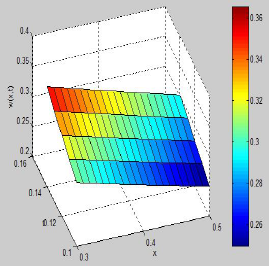
Fig. 3: Surface graph of w ( x , t ) of eq. (8.1), when α = 1